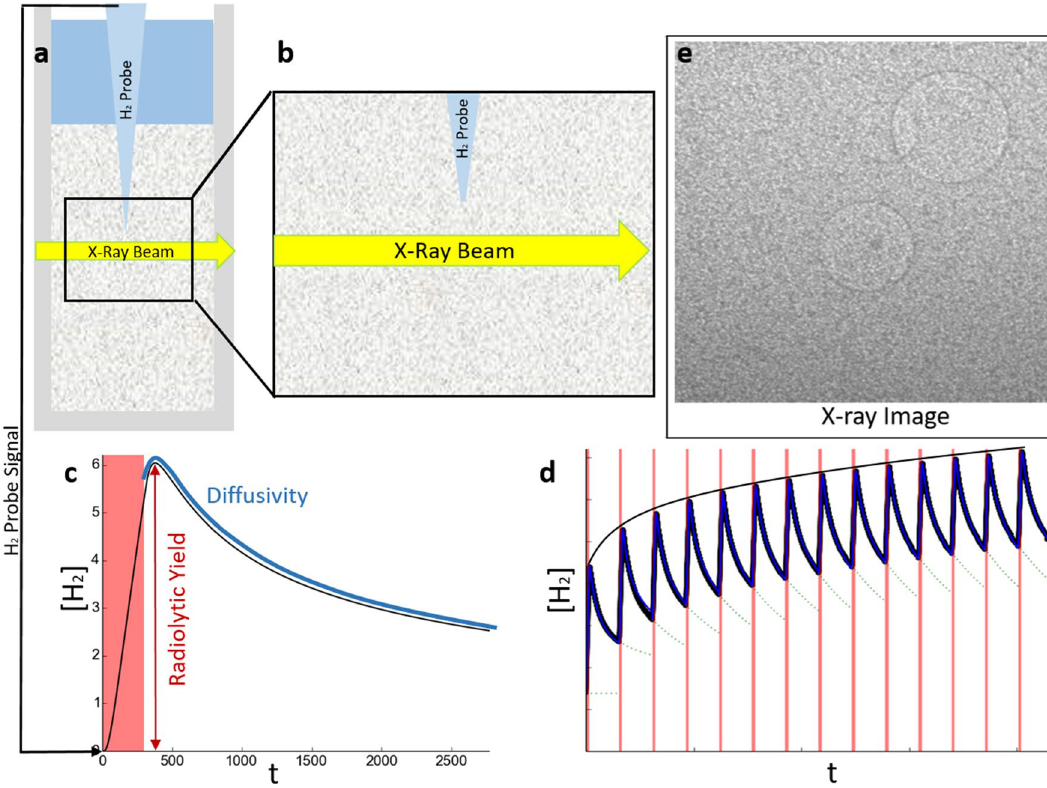
Figure 1. In a typical experiment, a cuvette filled with a nanoparticle sludge and hosting a hydrogen probe panel ( a ) was irradiated with a short and wide ribbon beam of monochromatic x-rays, approximately 1 mm below the tip of the probe, as illustrated in panel ( b ). The hydrogen probe signal was used to determine the radiolytic hydrogen yield and hydrogen diffusivity in the sludge, shown in panel ( c : the red region indicates when the sample was irradiated. Over many irradiations, the hydrogen yield decreased to a lower rate, as depicted in panel ( d ) and indicated with the envelope curve. This decrease indicates radiolytic consumption, which we quantify in this paper. In a separate experiment, the sample was instead irradiated with an intense white beam from the B16 bending magnet source. A 2 mm × 2 mm x-ray image from the white beam irradiation, panel ( e ), shows the formation of bubbles. Figure made with plots plotted with matplotlib 55 and an image processed by FIJI 56